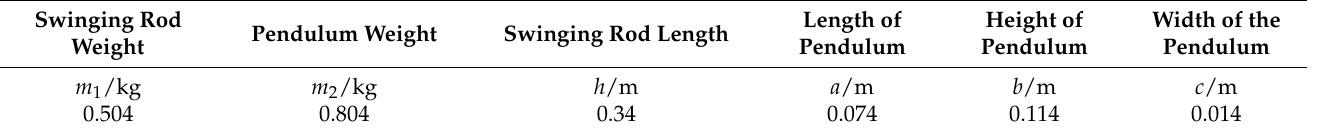
Table 6. Parameter values of impact mechanics test bench.